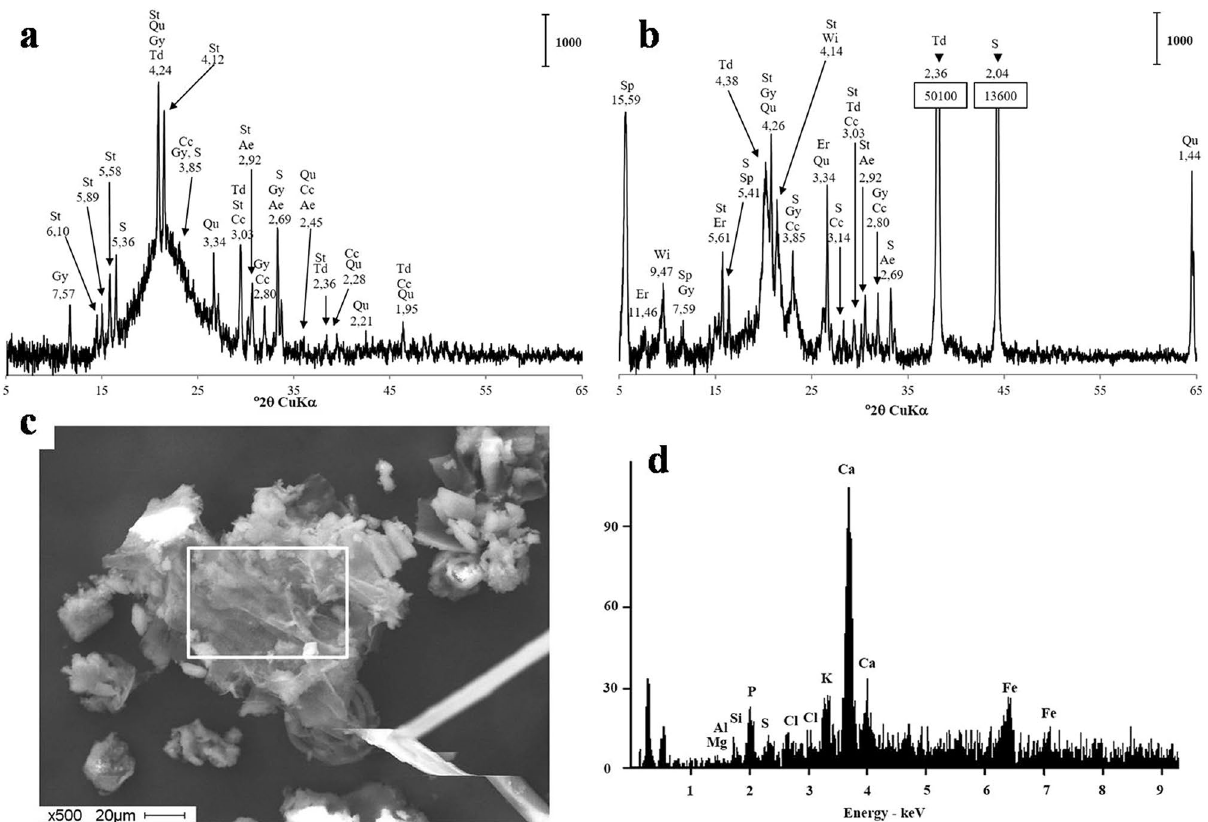
Figure 3. The X-ray diffractograms show the mineralogical composition of the sediment from the solid–liquid separation lagoon, sample Tom1 ( a ) and manure slurry, sample Tom3 ( b ). The vertical bar shows the scale of relative counts. Letter codes: Ae ankerite, Ca(Fe,Mg,Mn)(CO 3 ) 2 , Cc calcite, CaCO 3 , Er Erionite,